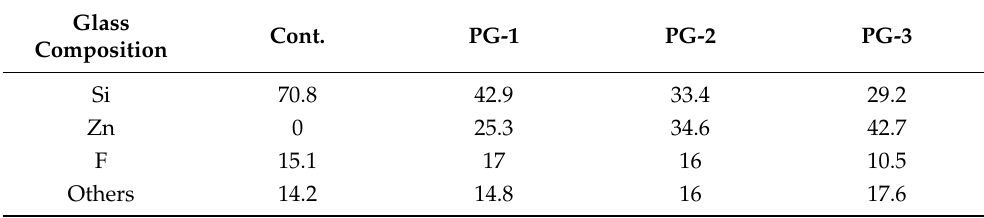
Figure 2. Elemental mapping images (EDS) images of the four glass particles. ( A ) Cont, ( B ) PG-1, 95 ( C ) PG-2, and ( D ) PG-3.